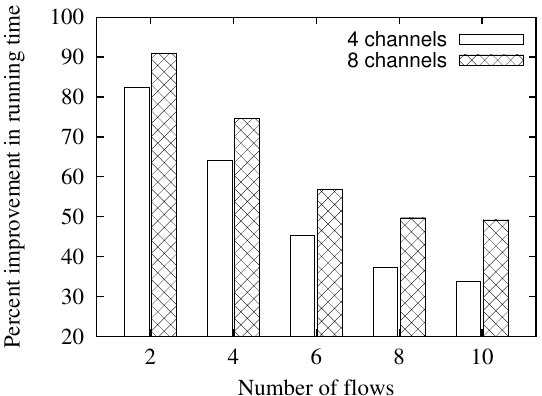
Figure 12. Percent improvement of running time in between pure genetic algorithm and the combination of backtracking and genetic algorithm based channel